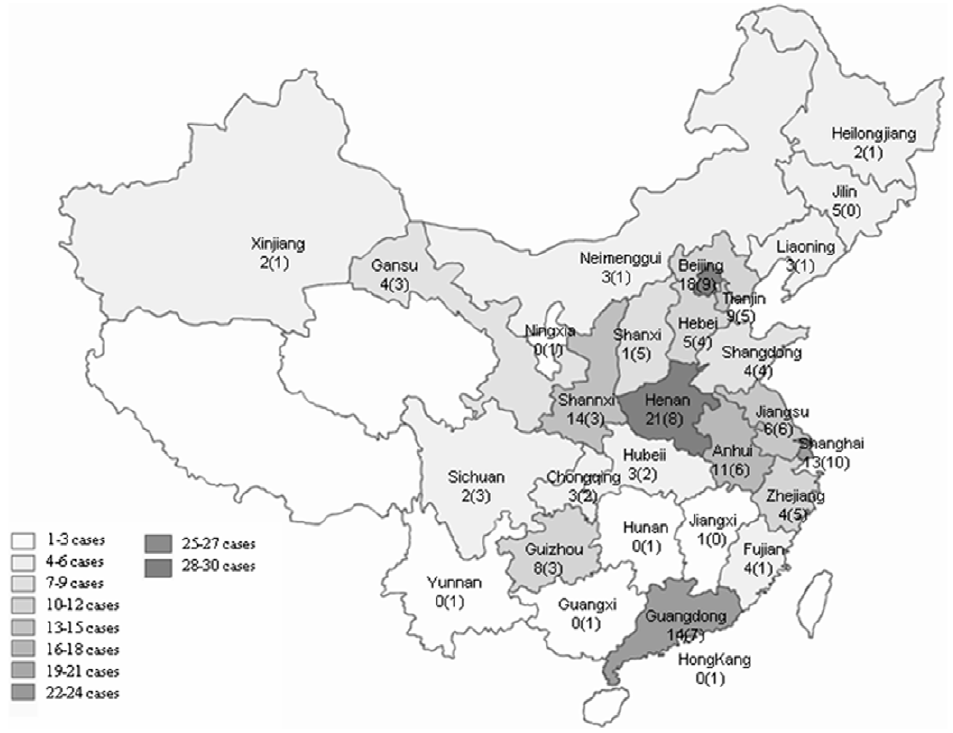
Figure 2. The geographic distribution of probable and possible sCJD cases based on the permanent residences. The numbers of probable and possible sCJD cases in each province were showed as X (X), respectively.